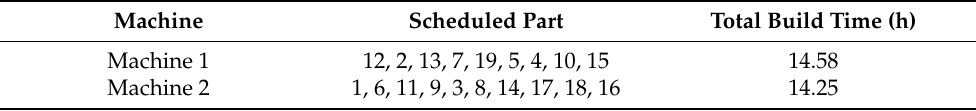
Table 2. Allocation of the